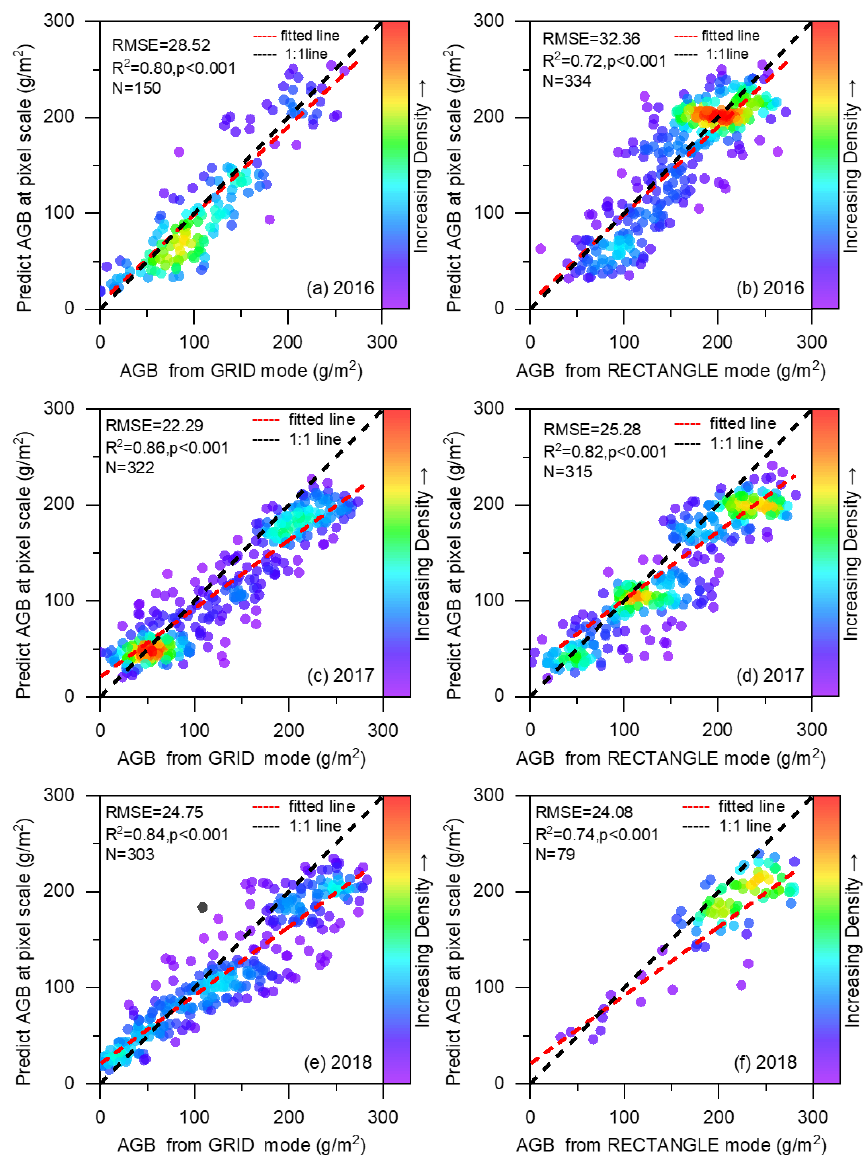
Figure 11. Comparison of the validation results for the GRID (a, c, e) and RECTANGLE (b, d, f) modes in